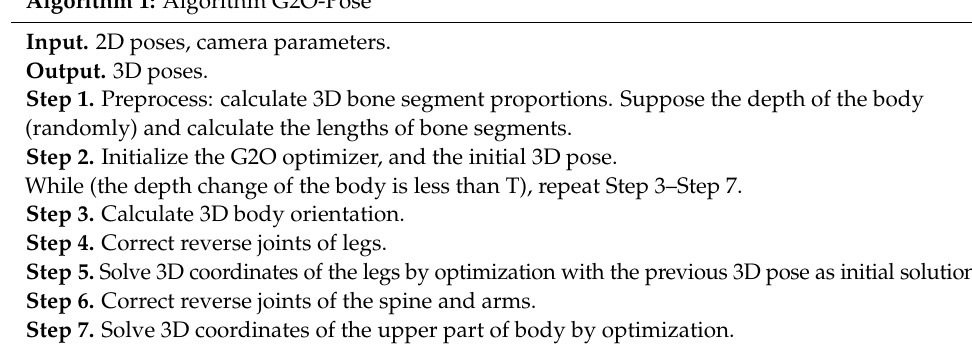
Algorithm 1: Algorithm